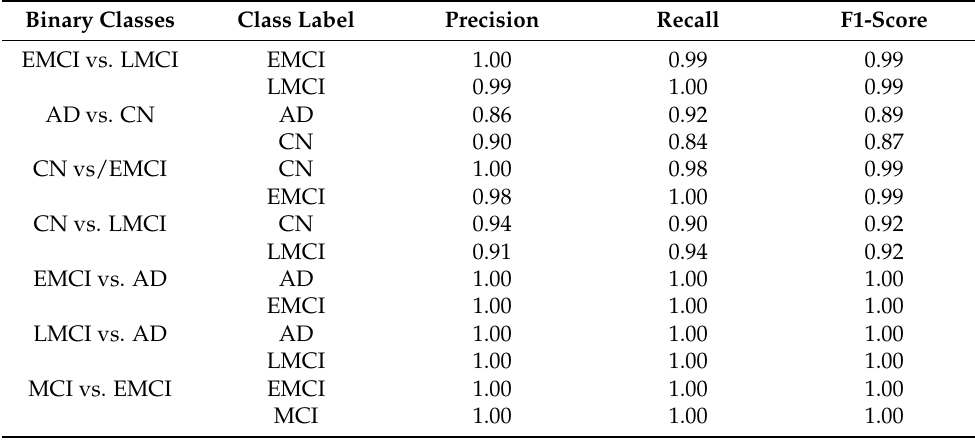
Table 8. Precision, recall, and f1-score for seven binary classification